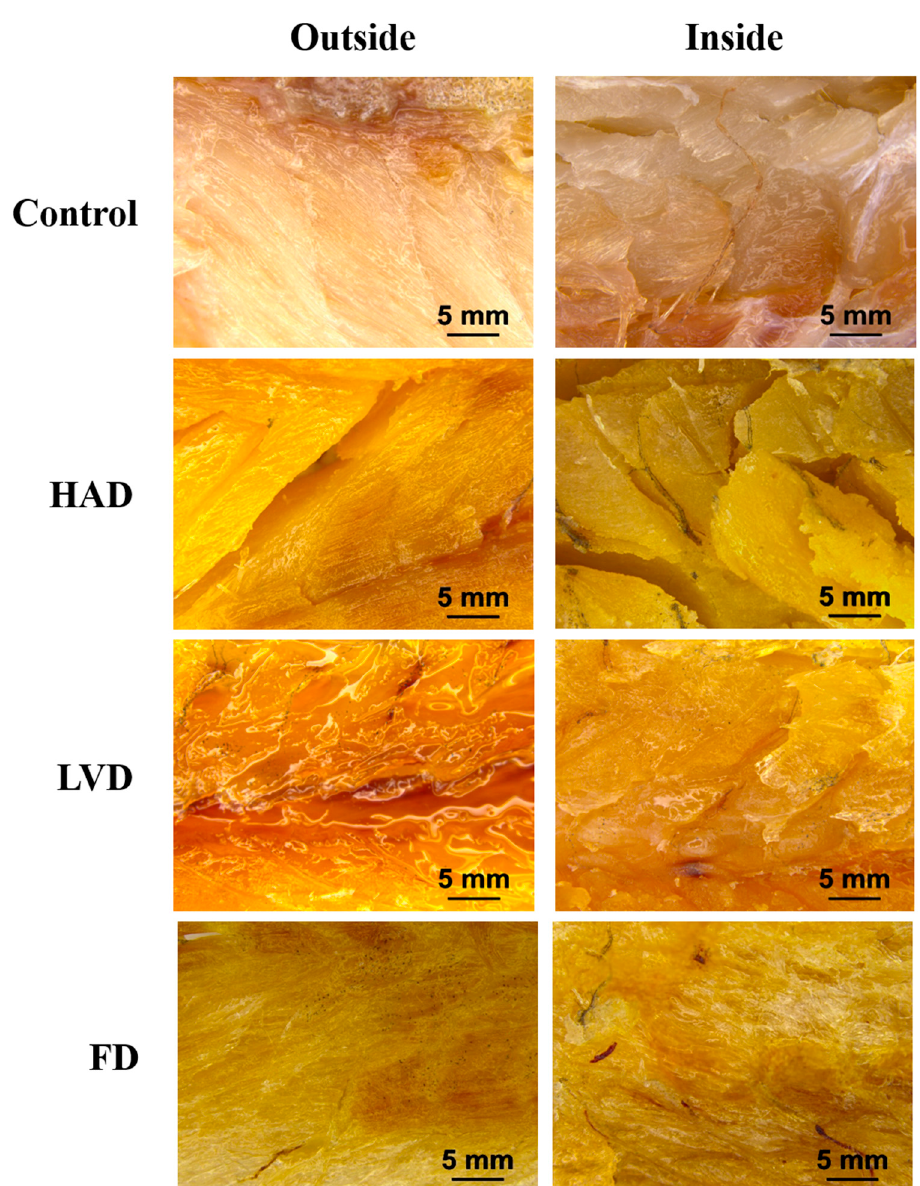
Figure 3. Outside (left) and inside (right) longitudinal section of stereo-micrographs in the yellow croakers by various drying methods. Scale bars: 5 mm. Control, yellow croakers by cold air drying to remove moisture. HAD, yellow croakers by hot air drying. LVD, yellow croakers by low temperature vacuum drying. FD, yellow croakers by freeze drying.